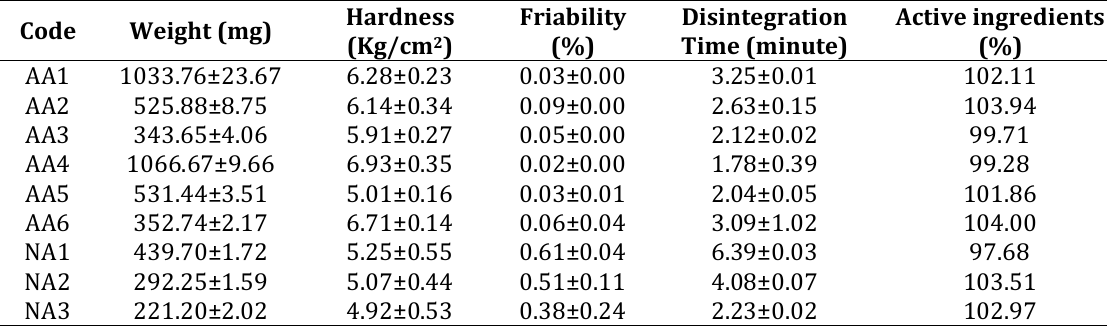
Table III. Characteristics of atorvastatin calcium’s liquisolid tablets